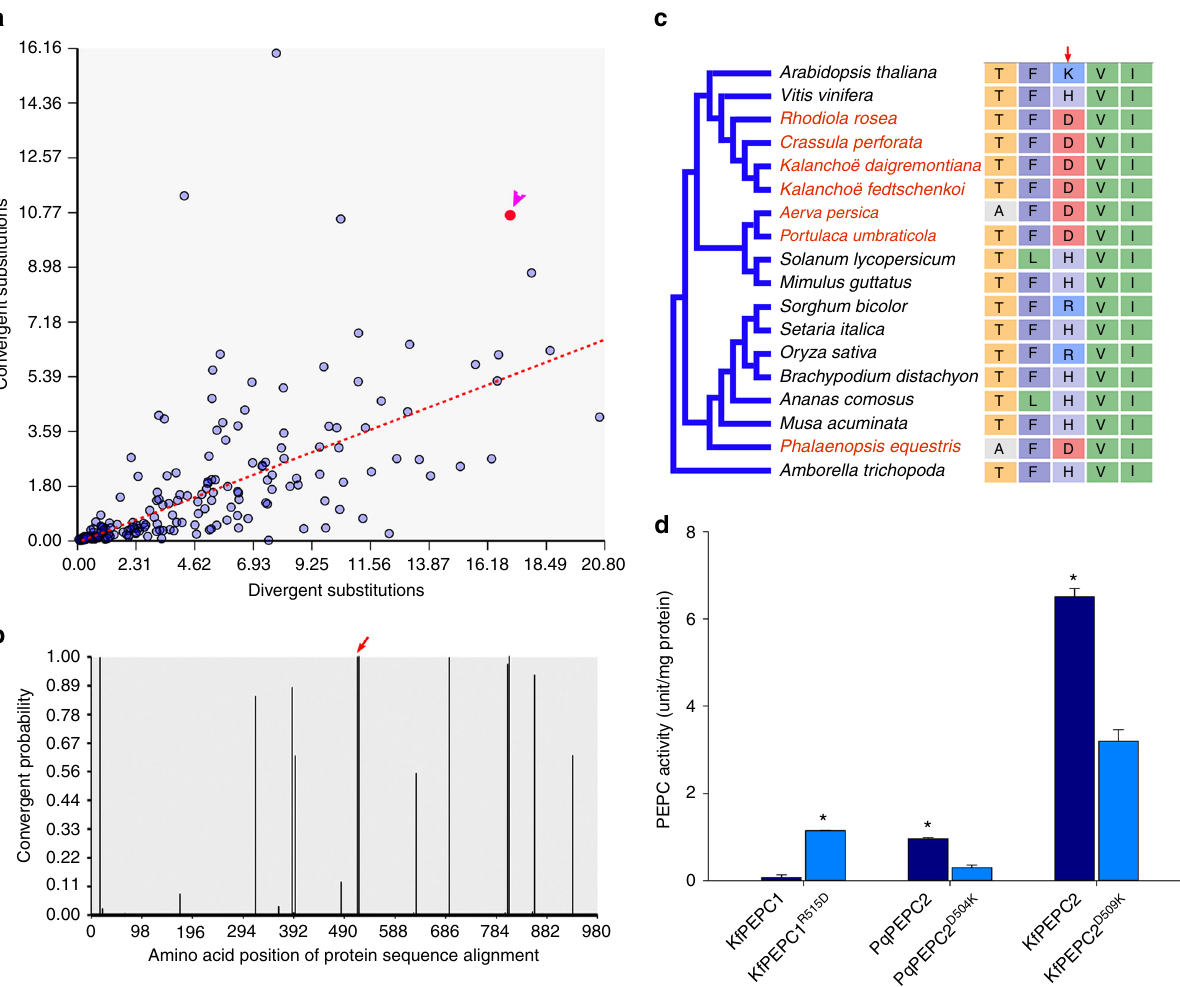
PEPC2 protein sequences between species listed in Supplementary Table 9. The arrow head indicates the comparison of K. fedtschenkoi vs. P. equestris